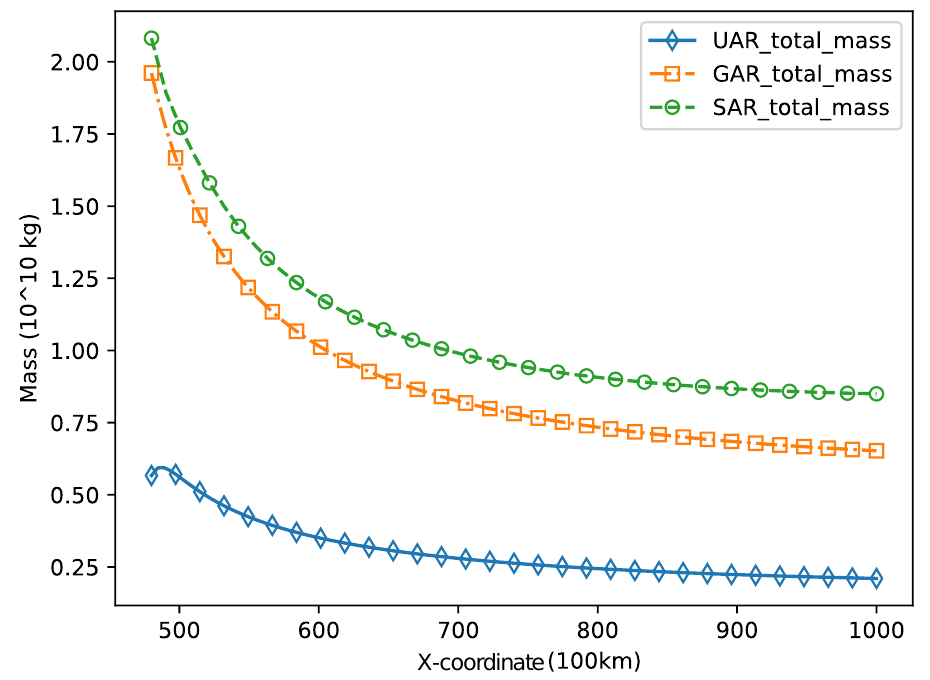
Figure 15. Total mass and rope length curve of three space elevator